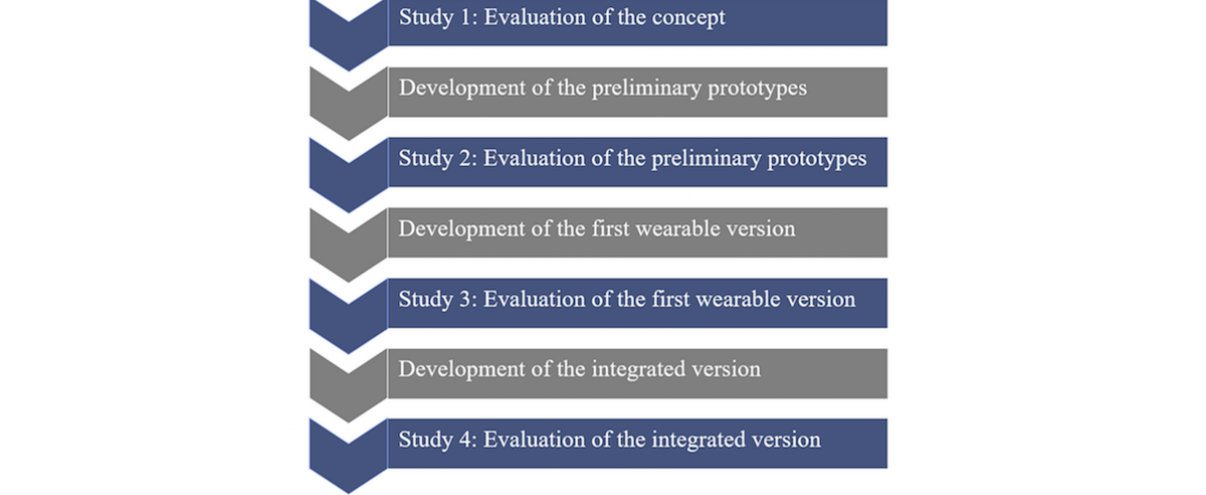
Figure 2. Flowchart indicating how the evaluation studies (blue) relate to the development stages of the SPLENDID eating detection sensor